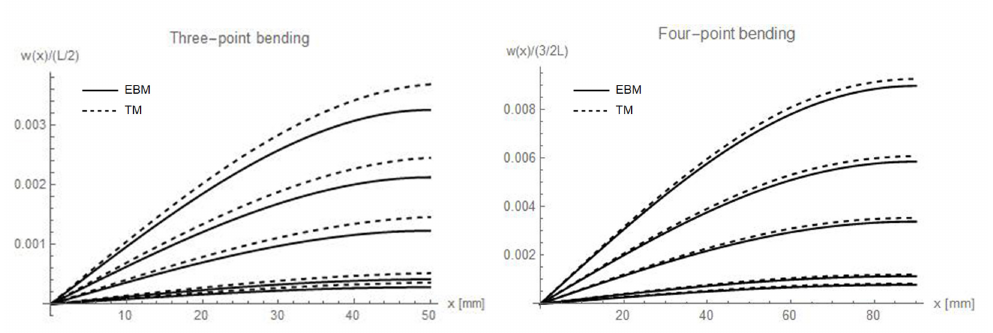
Figure 2. Normalised deflections with respect to the half of the total free length of the beams, i.e., L/2 = 50 mm for three-point bending and 3/2 L = 90 mm for four-point bending, along x axis, varying values of n . The fixed value of the load is 2000 N, while the assumed n values are, from top to bottom, respectively n = 0.03; 0.05; 0.1; 0.5 and 1 (which is the mono-modulus